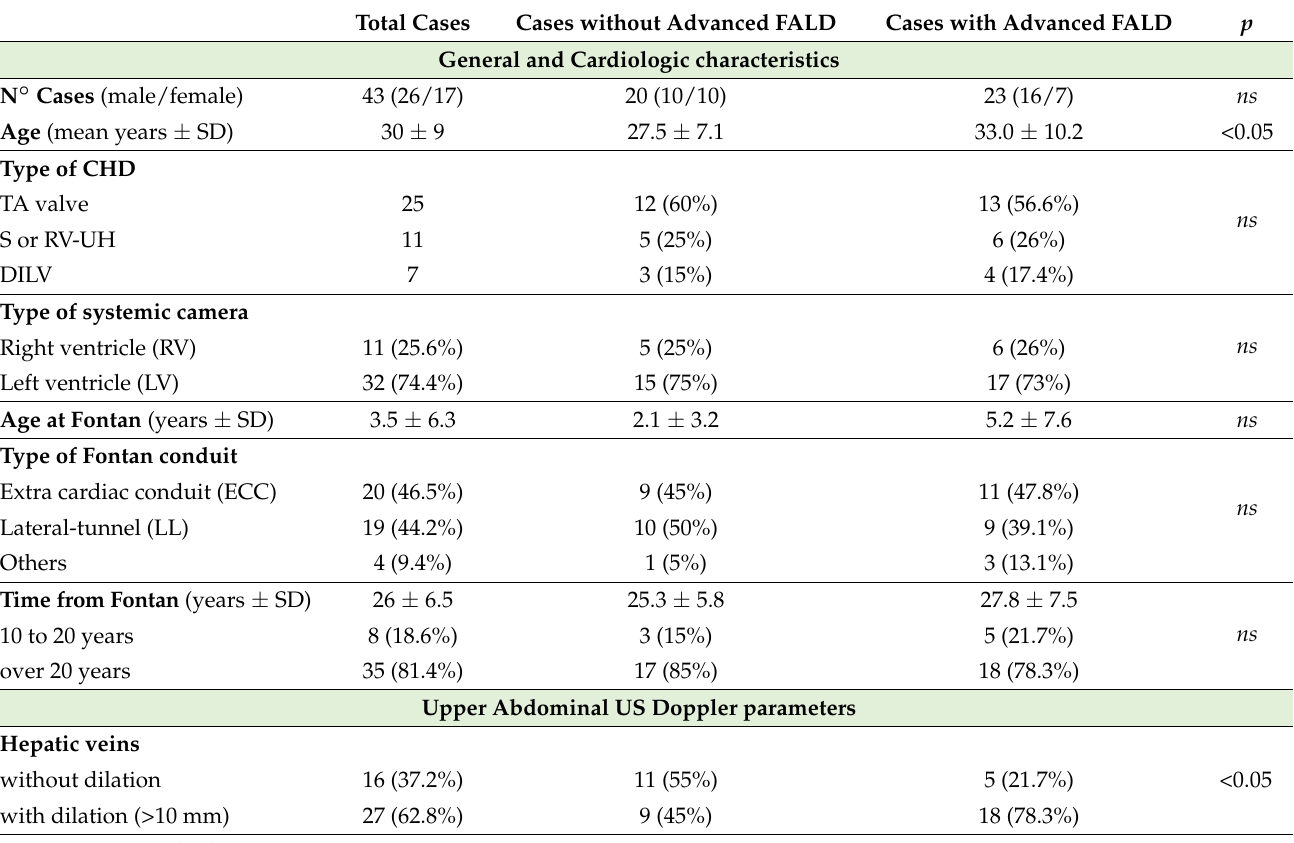
Table 1. Characteristics of study